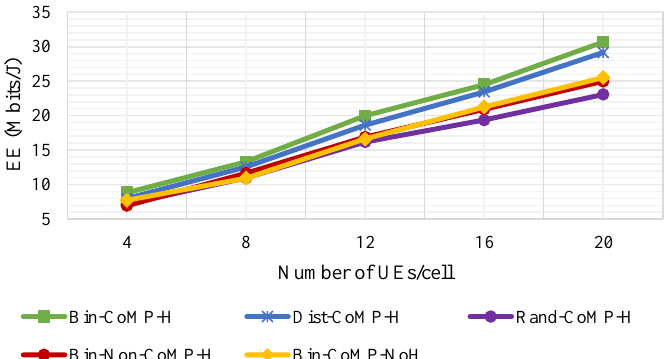
Figure 8. EE for increasing number of UEs per cell analysed for different BS-Sw methods and BS coordination techniques with E HC